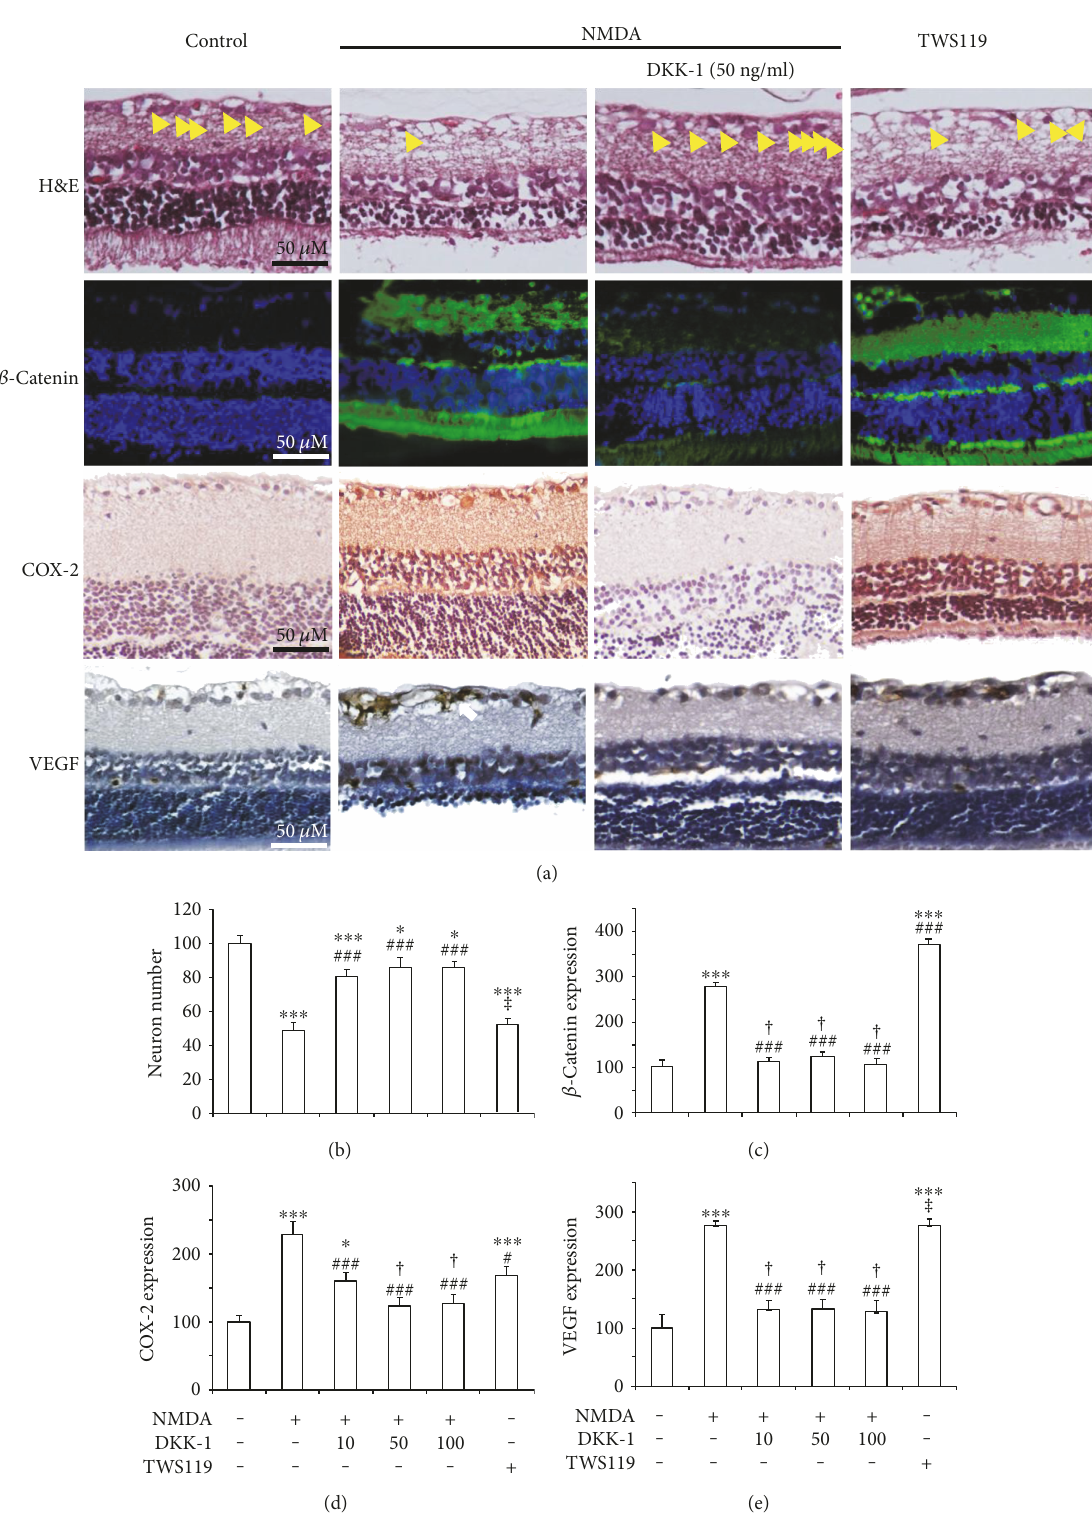
Figure 2: The Wnt/ β -catenin pathway was activated in the retinopathy caused by NMDA. (a) Representative images (H&E staining, expression of β -catenin, COX-2, and VEGF) of the rats. (b) Neuron numbers of RGCs with respect to control (untreated), in NMDA- injected retinas of animals treated with DKK-1. (c) β -Catenin expression of retinas with respect to control (untreated), in NMDA-injected retinas of animals treated with DKK-1. (d) COX-2 expression of retinas with respect to control, in NMDA-injected retinas of animals treated with DKK-1. (e) VEGF expression of retinas with respect to control, in NMDA-injected retinas of animals treated with